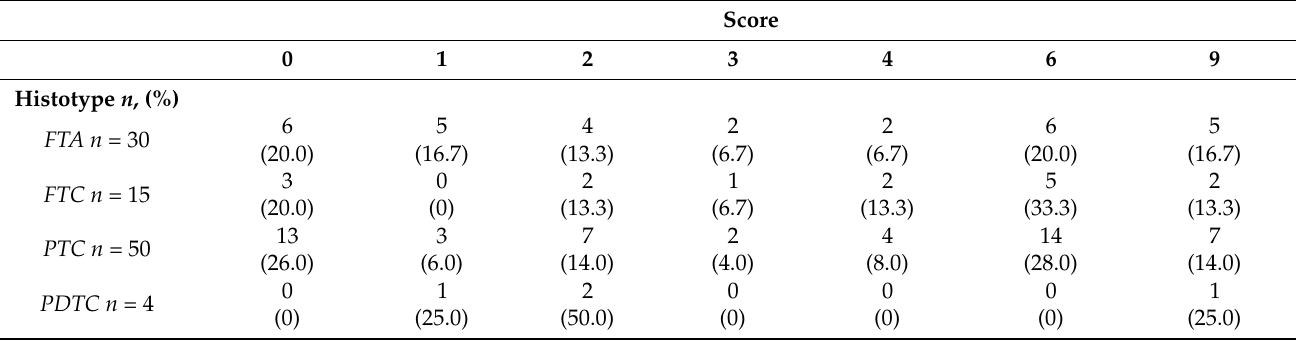
Table 2. Score values of DGCR8 immunoexpression in the different histotypes.